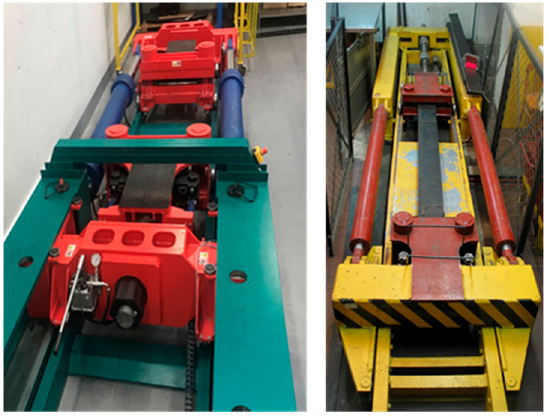
Figure 6. Test stands.